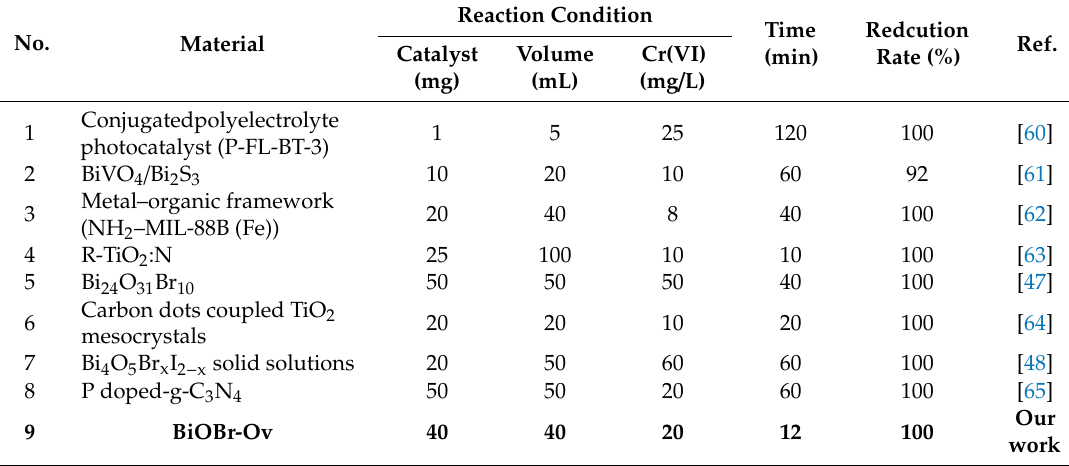
Table 1. Brief summary of recently reported materials for photocatalytic Cr(VI) reduction under visible light